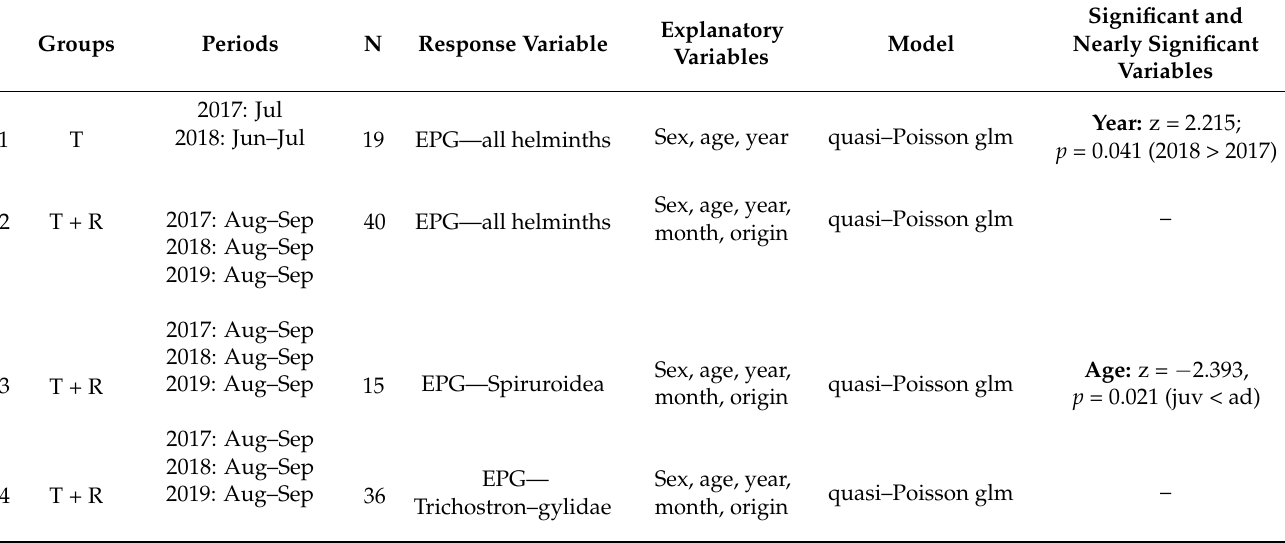
Table 6. Details of the statistical analyses applied with EPG as response variable. Glm—generalized linear model; T—translocated; R—resident.